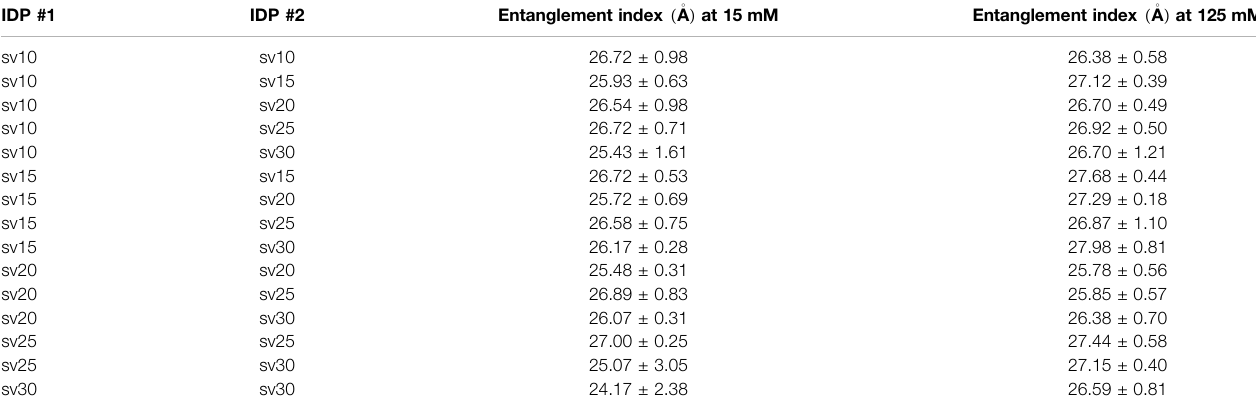
TABLE 2 | Summary of entanglement index values of all possible pair combinations between the fi ve (Glu-Lys) 25 IDP sequence variants. IDP